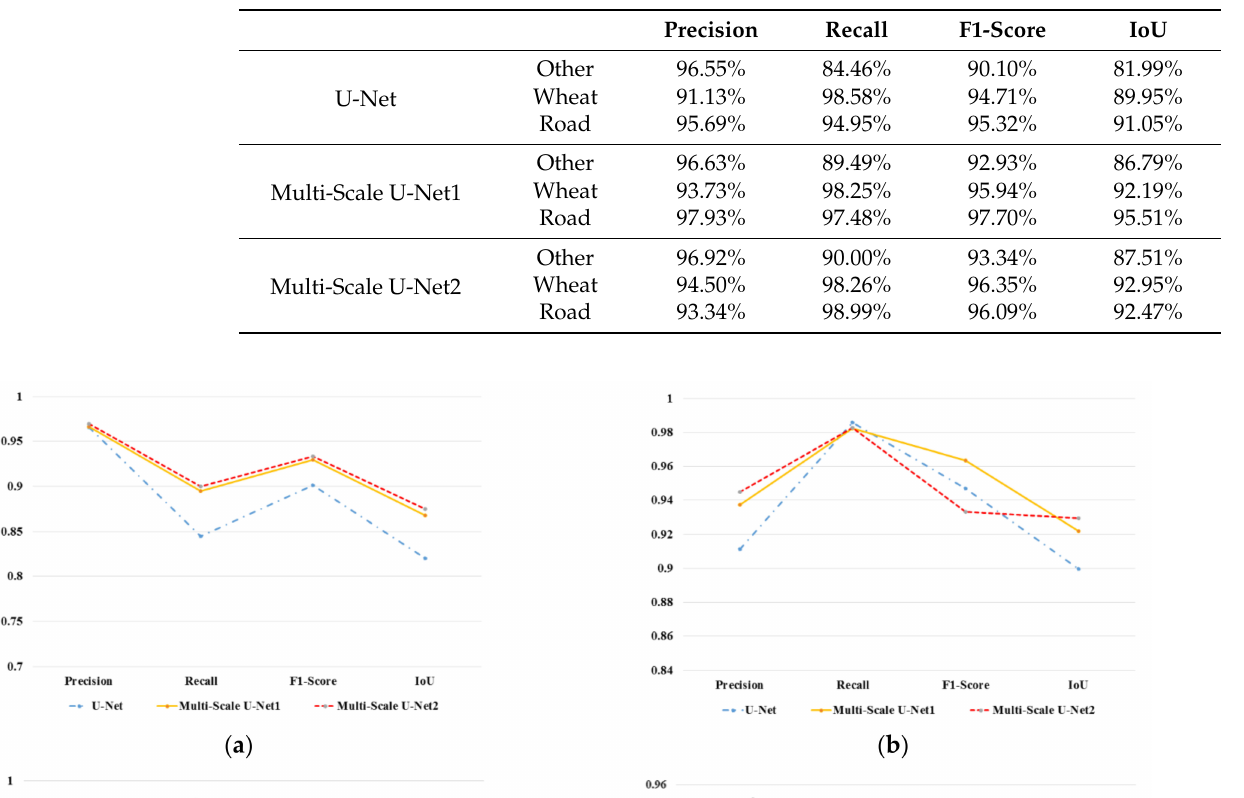
Table 8. Accuracy evaluation of Different categories under three Network Models.